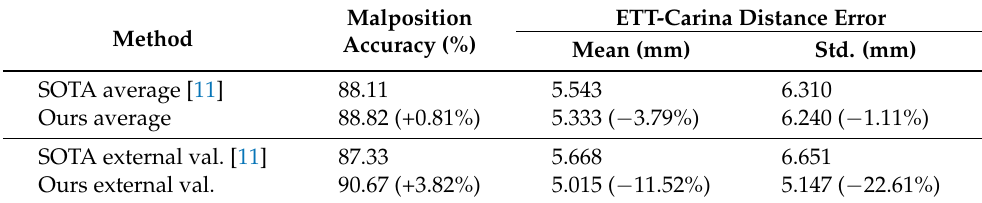
Table 9. The comparison results of accuracy and ETT–Carina distance error.